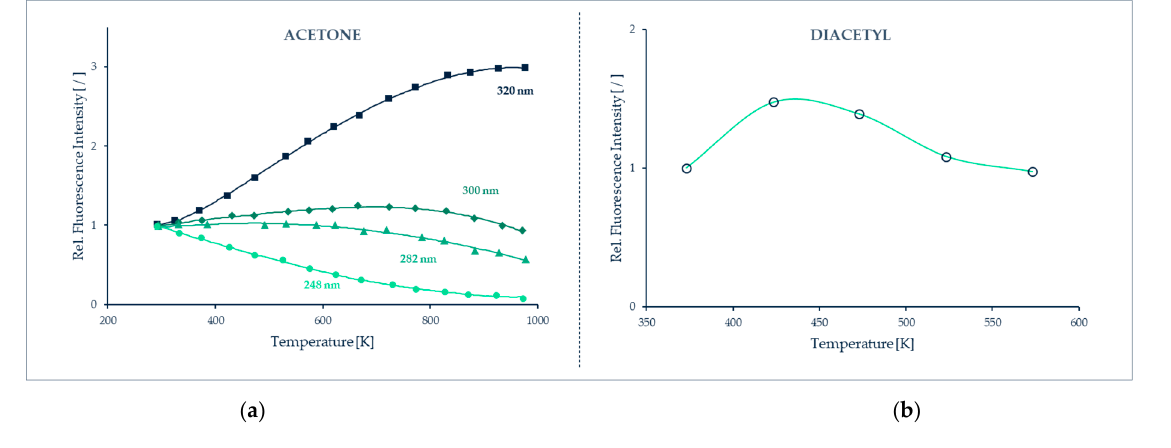
Figure 34. ( a ) Fluorescence emission signal per unit laser fluence of acetone vapor as a function of temperature for different laser excitation wavelengths, obtained by Thurber et al. [173]. The values are normalized by the emission signal obtained at room-temperature. ( b ) Fluorescence emission signal of diacetyl vapor in nitrogen as a function of temperature at a pressure of 0.1 MPa, obtained by Guibert et al. [181]. Data from [173,181].